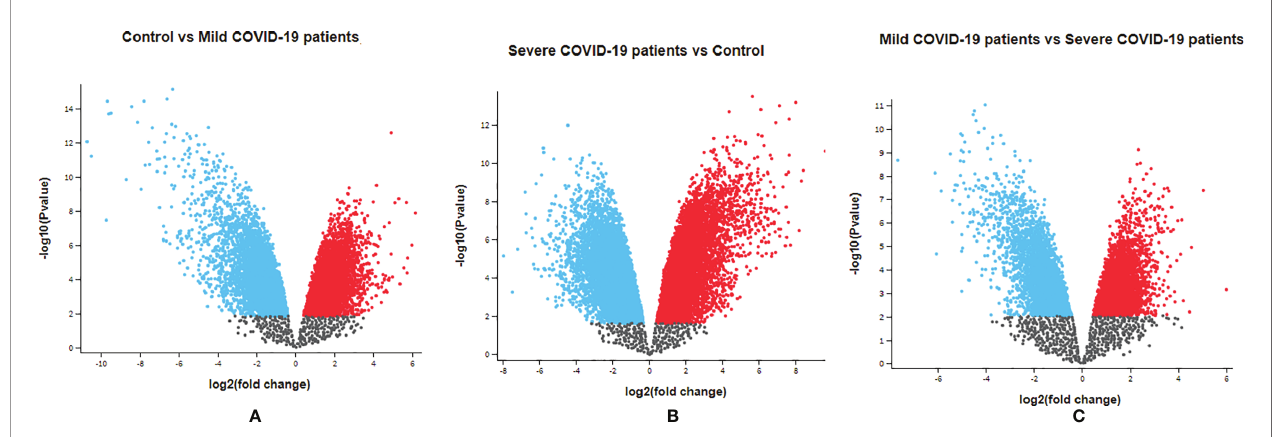
FIGURE 2 | Visualization of identi fi ed DEGs using volcano plots . (A) DEG volcano plot using the data of control vs. mild COVID-19 patients. (B) DEG volcano plot using the data of severe COVID-19 patients vs. control healthy volunteers. (C) DEG volcano plot using the data of mild COVID-19 patients vs. severe COVID-19 patients. In this fi gure, red dots denote upregulated DEGs and blue dots denote downregulated